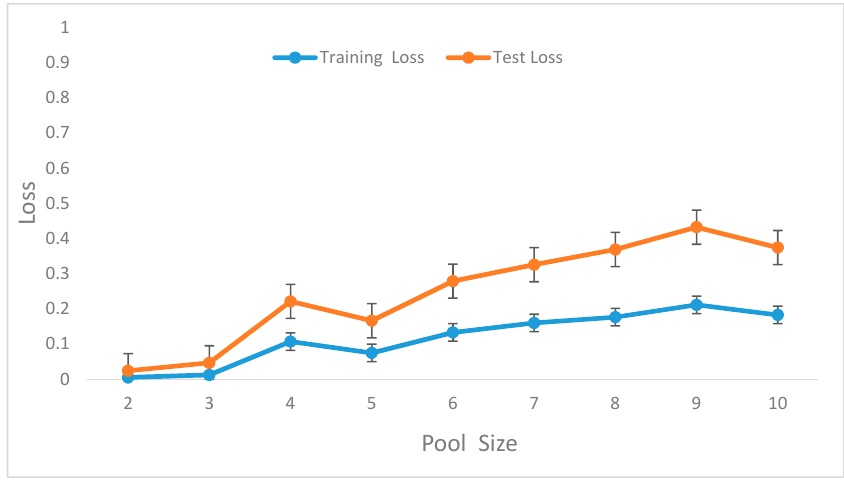
Figure 14. Recognition accuracy of the model for various values of pool size.